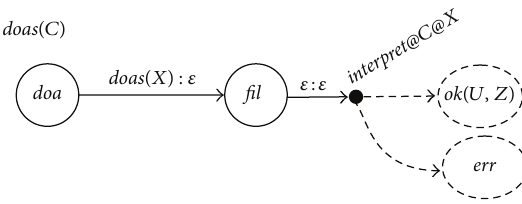
Figure 7: Dialogue model for simple DOA